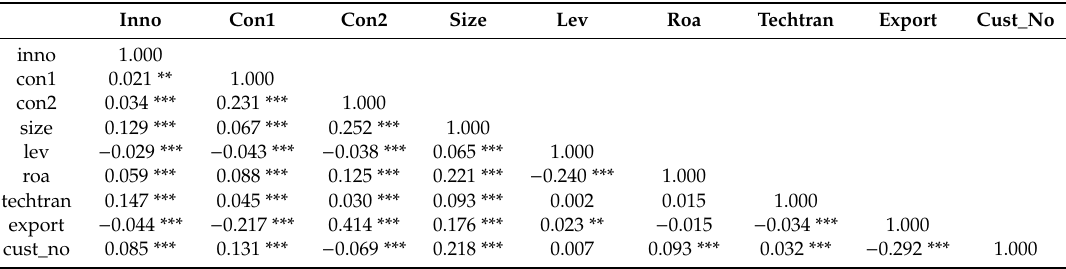
Table 2. Correlation